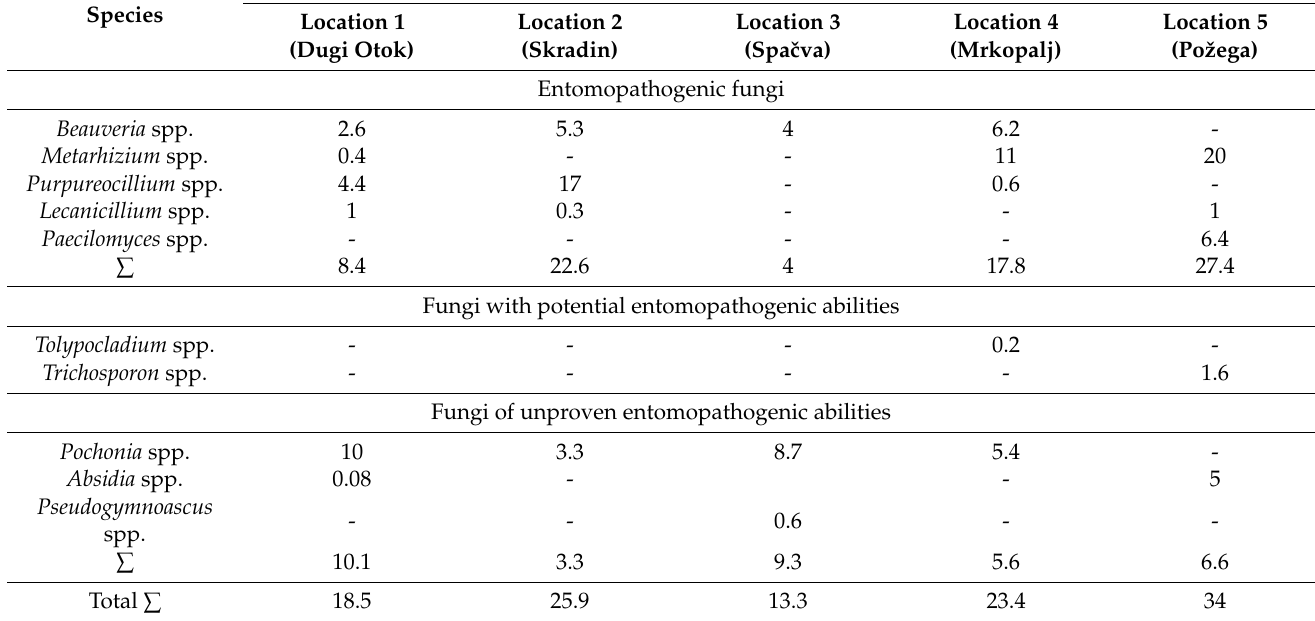
Table 2. Identified fungal species and the density of their colony-forming units (CFU × 10 3 g − 1 ) in soil.